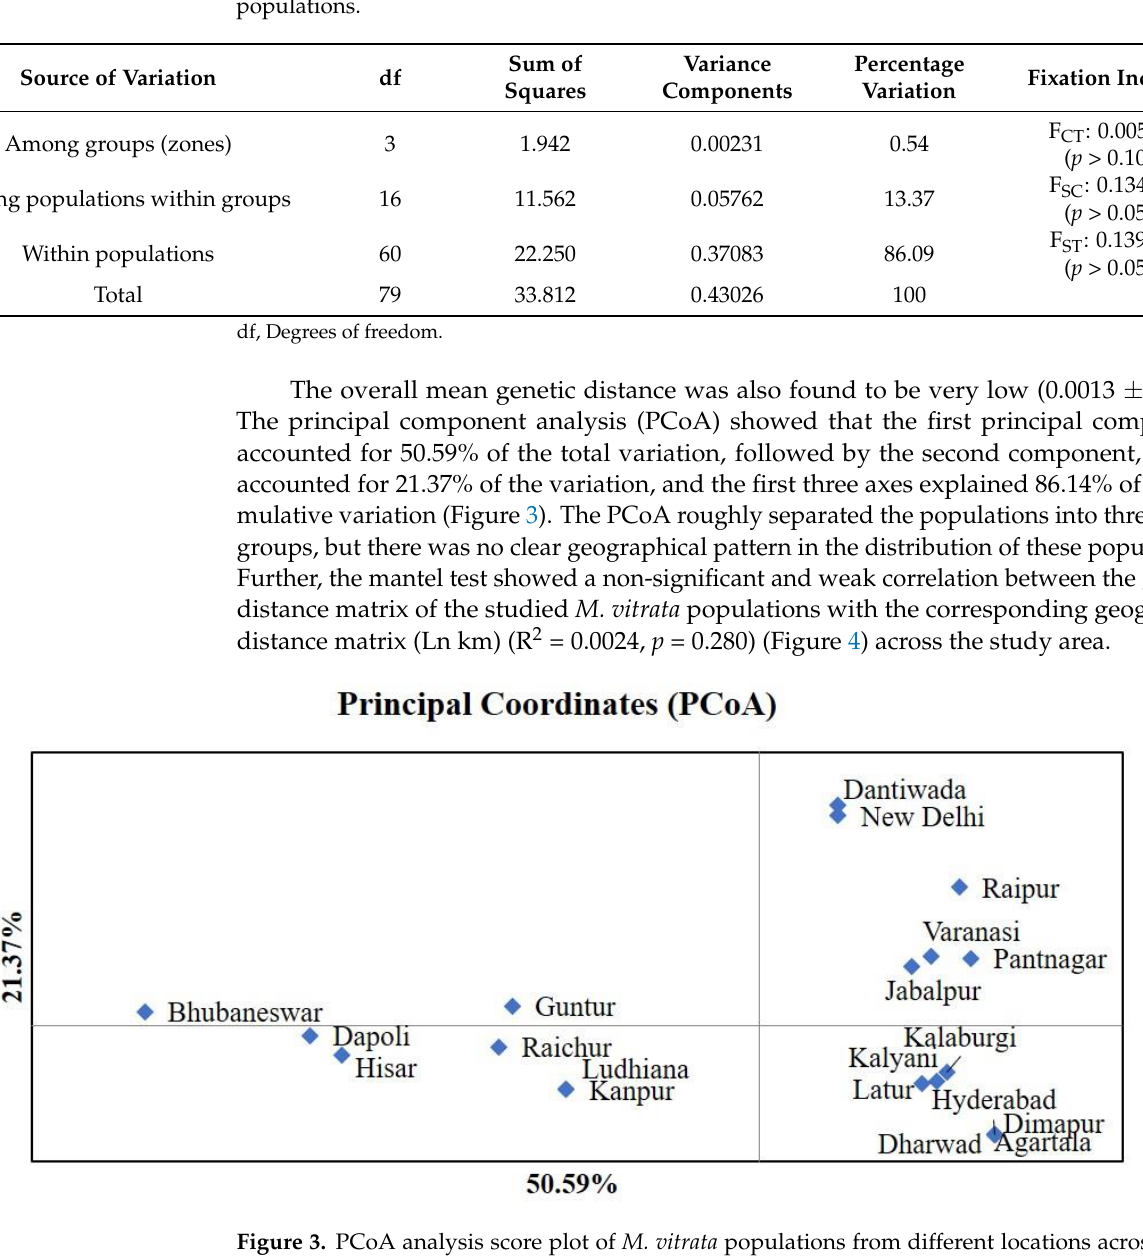
y = 2×10 -5 x + 0.0876 R² = 0.0024